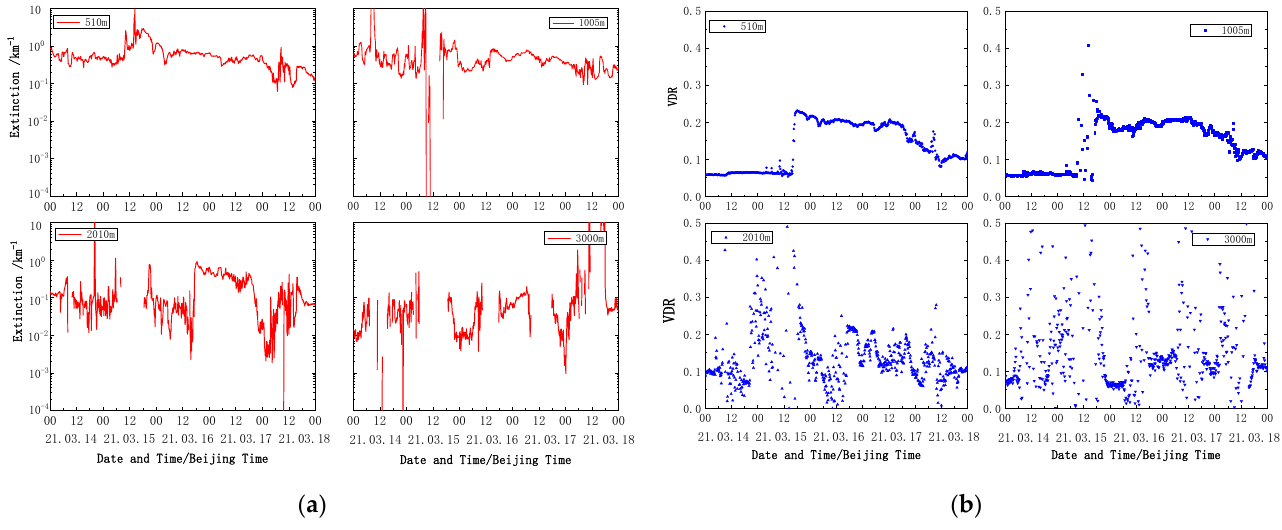
Figure 5. Time distribution of the extinction coefficient ( a ) and the VDR ( b ) at several typical heights. Figure 6 depicts the curve of the extinction coefficient at 495 m and the mass concen- tration of ground PM10 with time. It can be seen that the changing trend is basically in line, but the change in ground PM10 mass concentration (with the maximum value lager